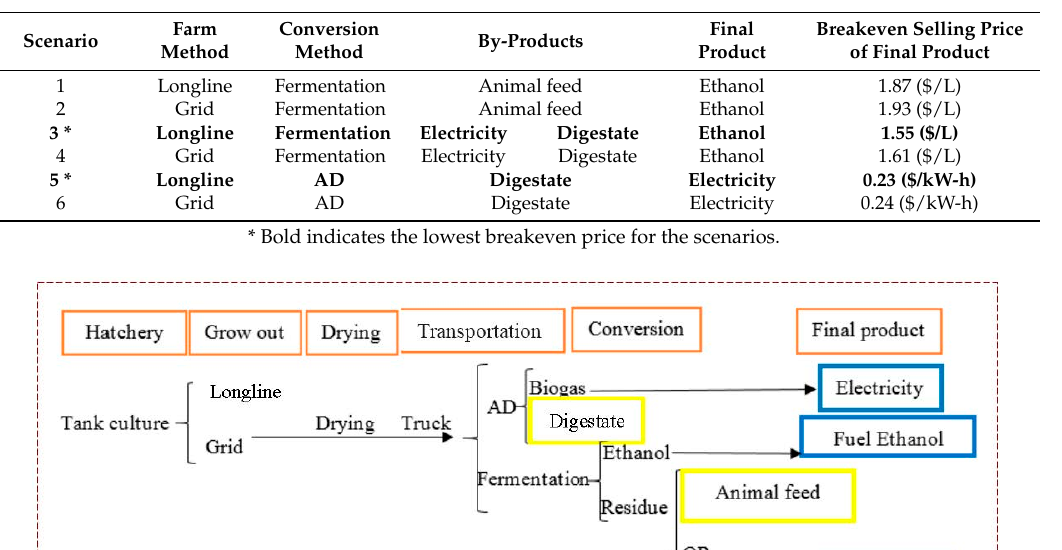
Table 1. Scenarios analyzed in this study, and resulting in breakeven selling prices for the different scenarios.